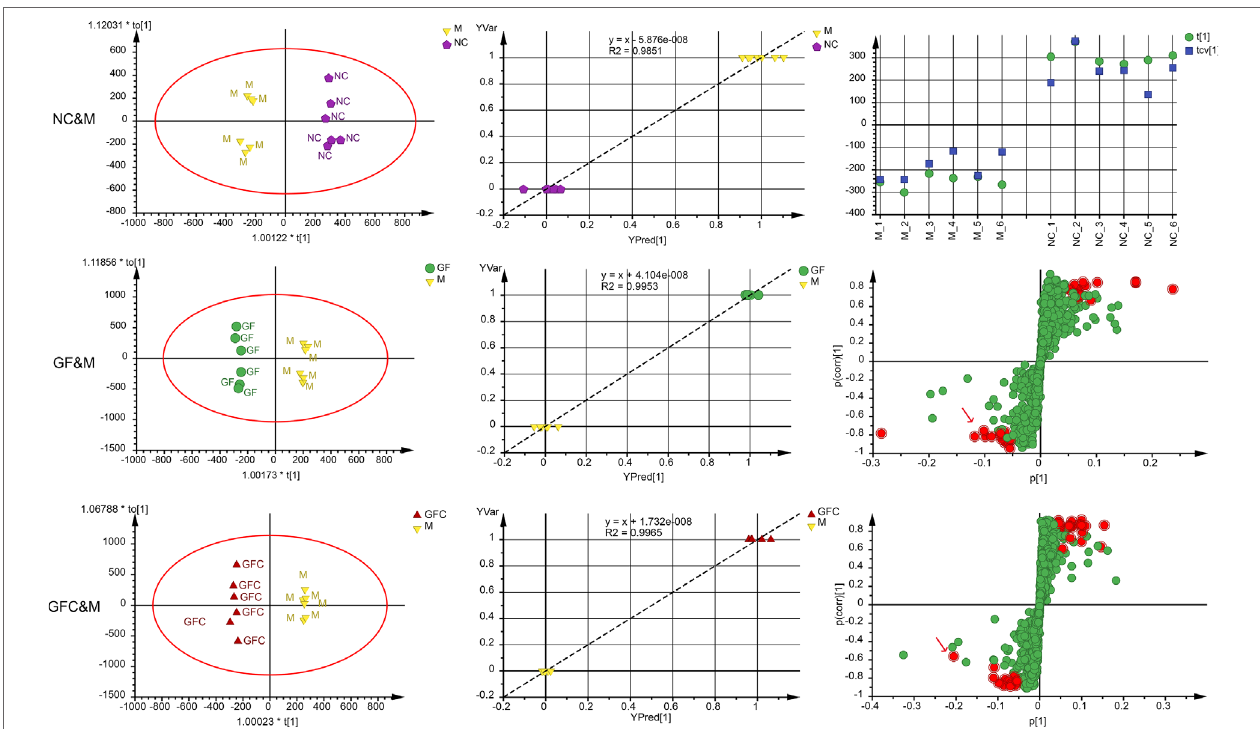
FIGURE 5 | Score plots, observation versus predicted plots, CV-plot (NC&M), and s-plots using OPLS-DA in the HILIC/UHPLC/MS system. Red points (red arrows) in s-plots show the putative ion features with 95%